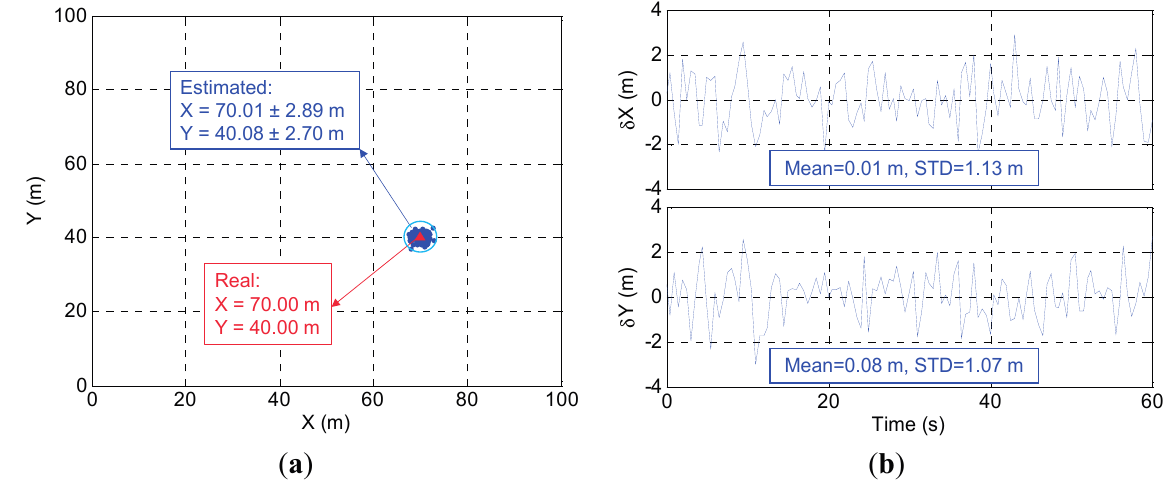
Figure 8. Static test results: ( a ) positioning results and ( b ) positioning error.